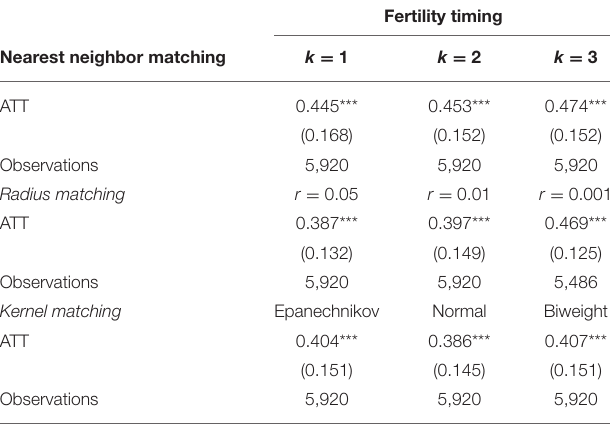
TABLE 4 | Fixed-effect estimates for the impact of off-farm employment on fertility timing.